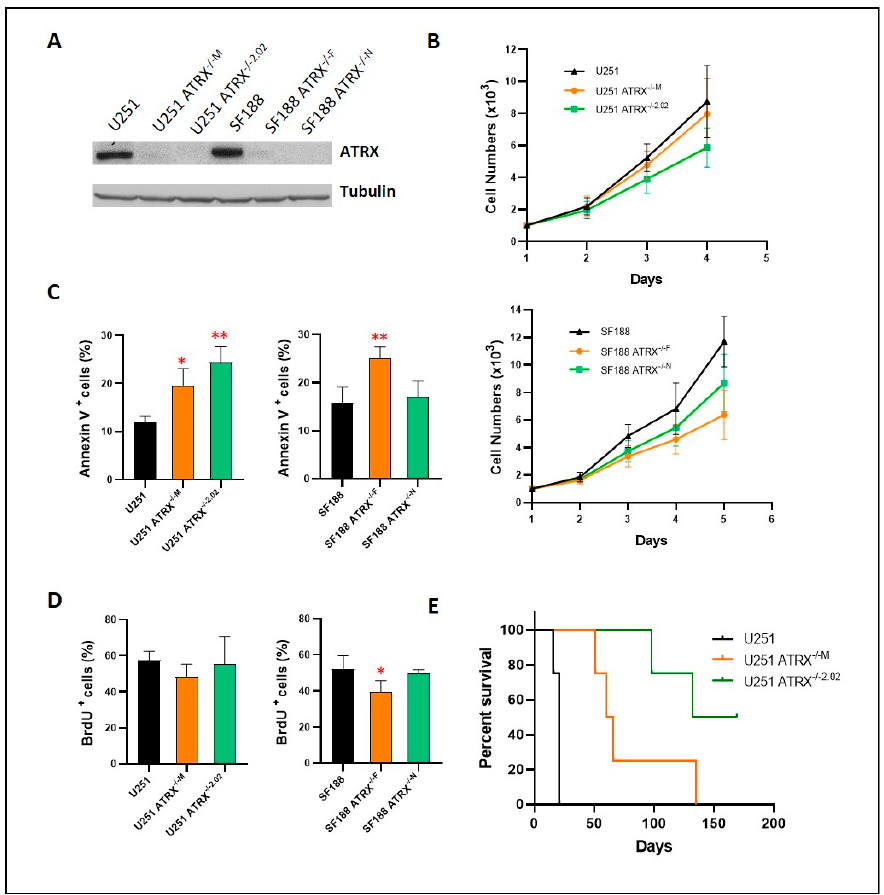
Figure 3. ATRX knockout in NF1-deficient glioblastoma cell lines U251 and SF188: Successful ATRX knockout in both glioma lines at the protein level ( A ). Decreased cell growth, primarily secondary to apoptosis, was noted in vitro ( B , C ), with mild to no effect on proliferation ( D ). ATRX knockout in U251 resulted in decreased tumor growth in orthotopic nude mouse xenografts ( E ). (* p < 0.05, ** p < 0.01).